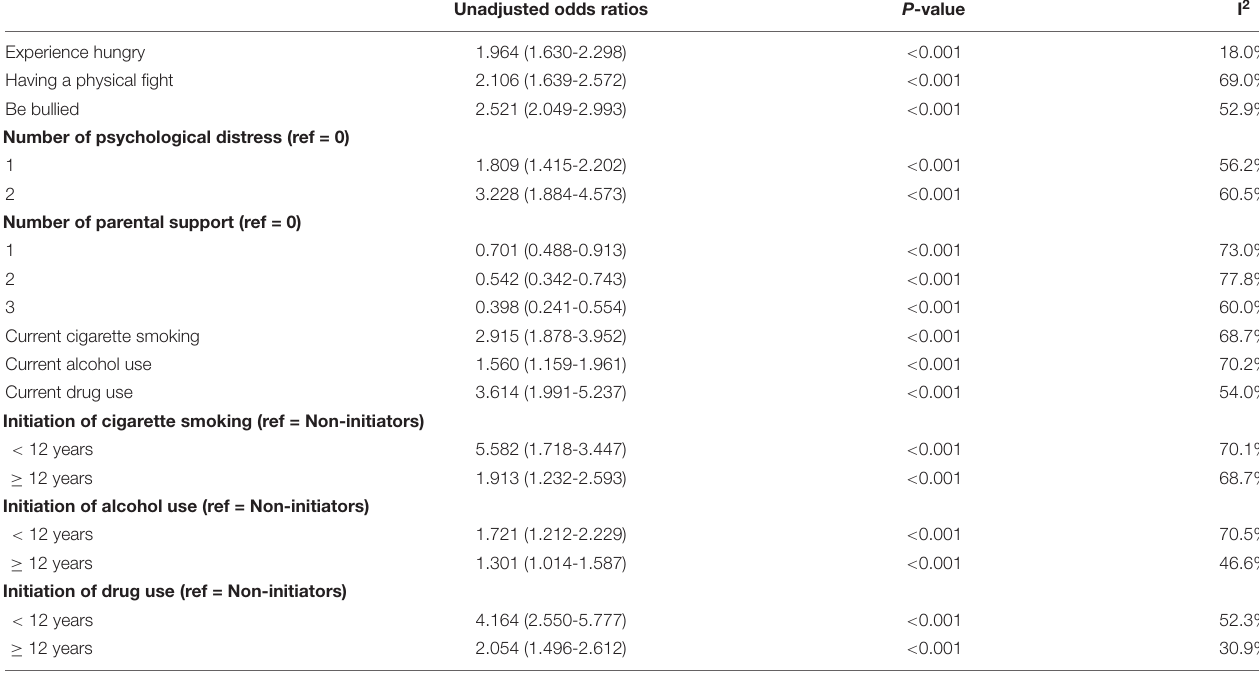
TABLE 2 | Unadjusted relationships between study variables and attempted suicide among in-school African adolescent. Unadjusted odds ratios